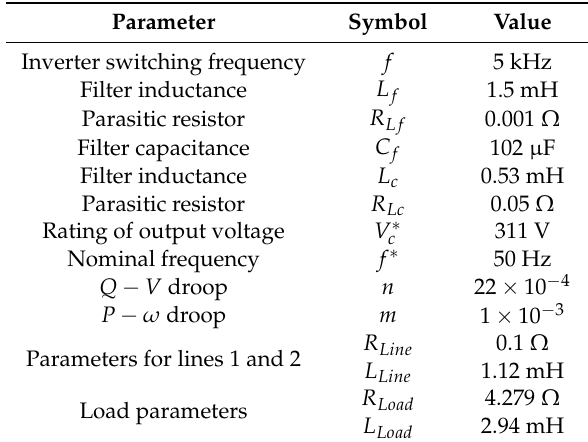
Table 1. Microgrid (MG)